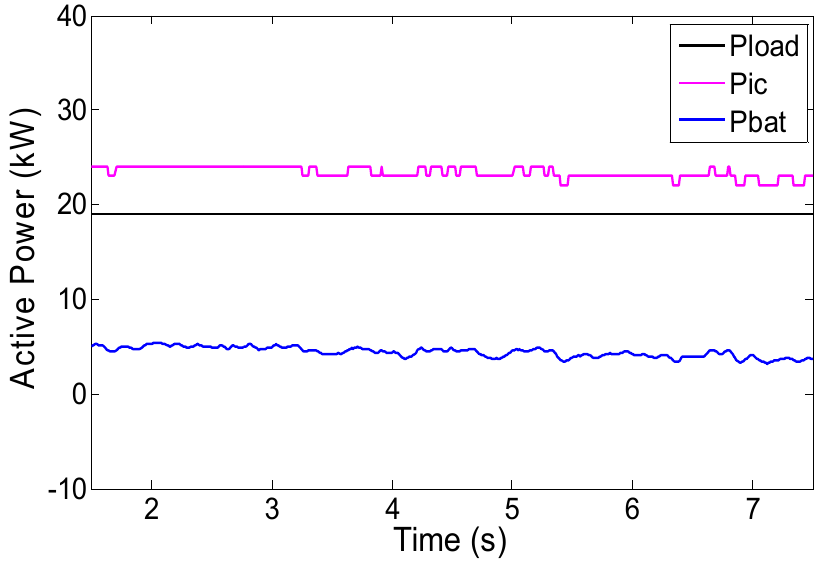
Figure 16. DC active power flow in the first case.